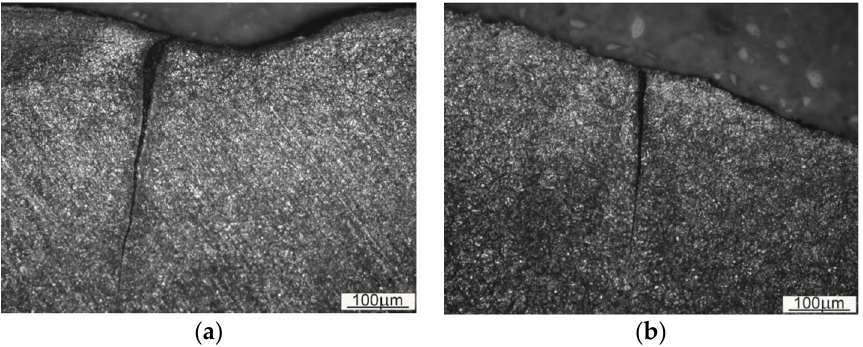
Figure 5. Microstructure of the top layer in the area of the die profile transition into an outer flash web: ( a ) in area 3b1 (Figure 3—area 3b1) and ( b ) in area 3b2 (Figure 3).